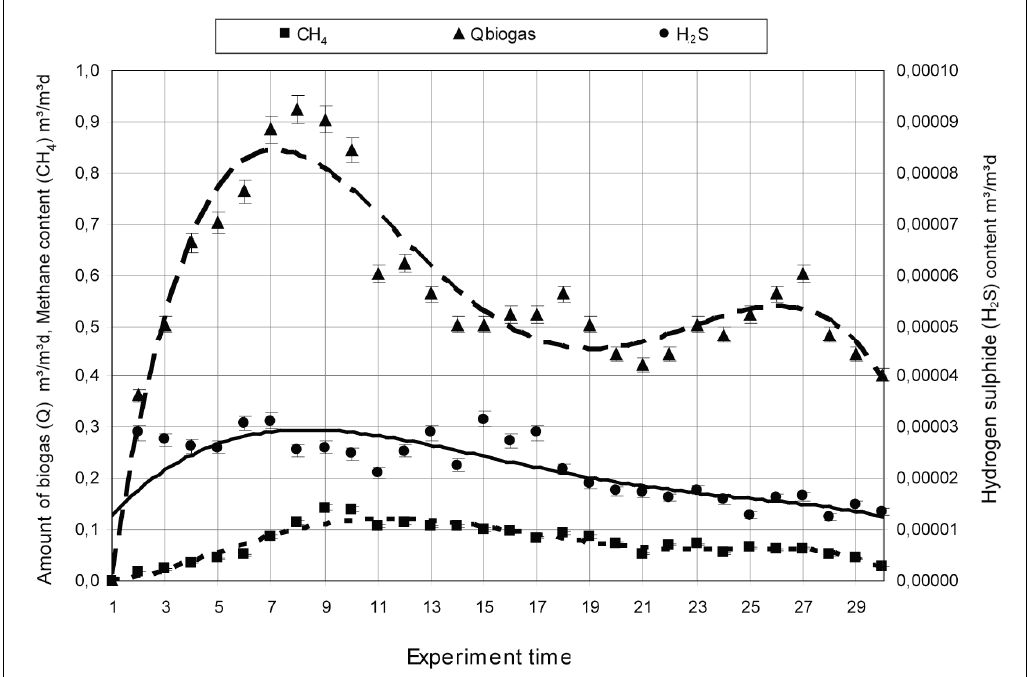
3 3 /m d), methane (m